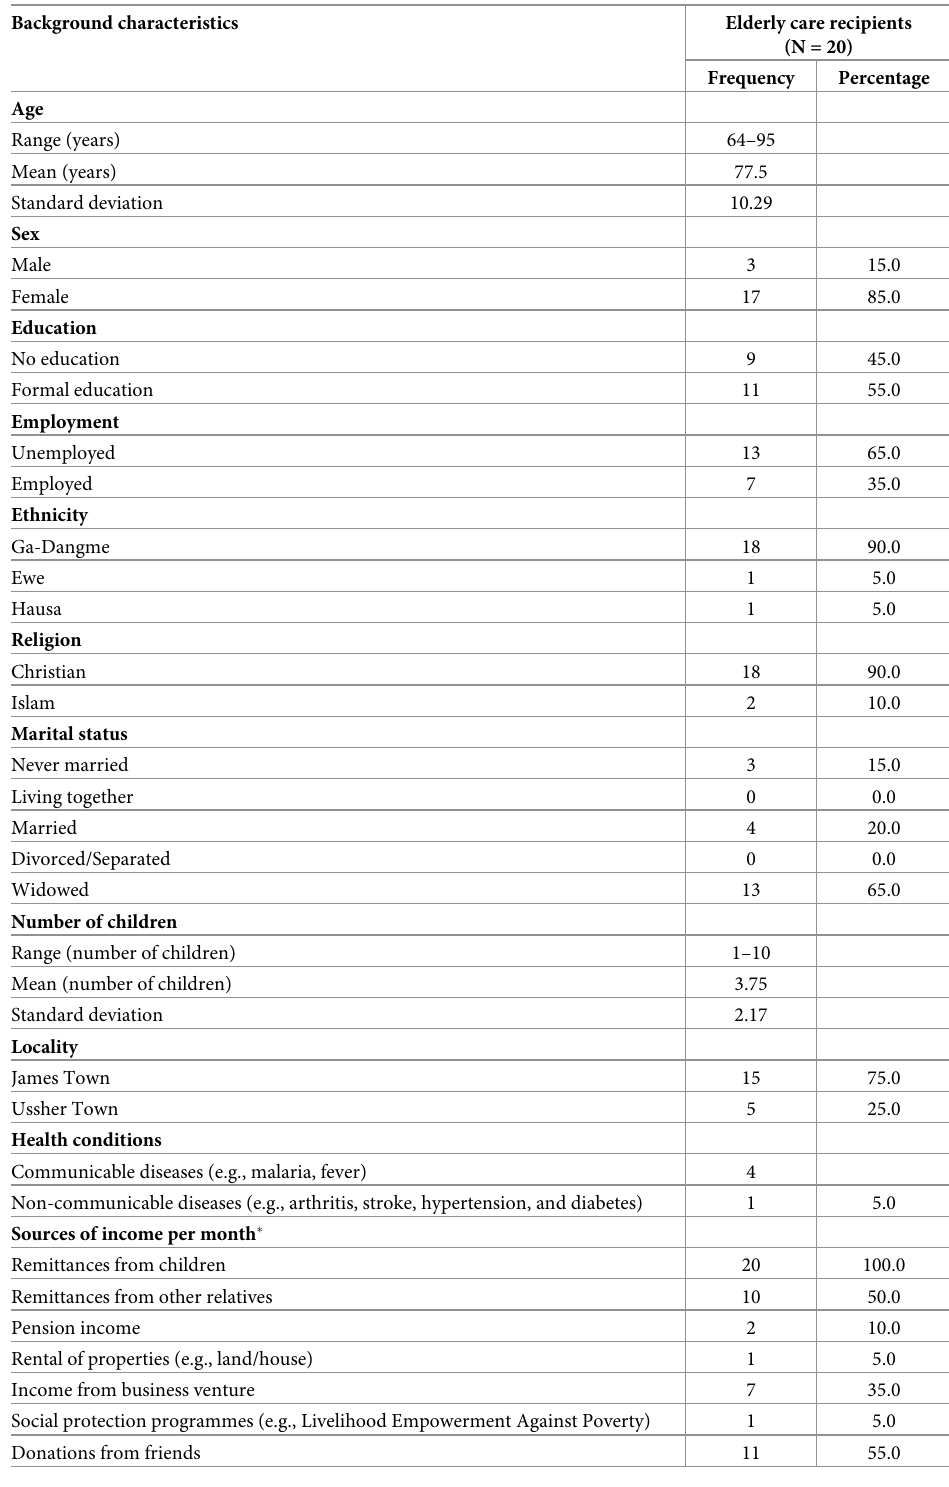
Table 3. Characteristics of care